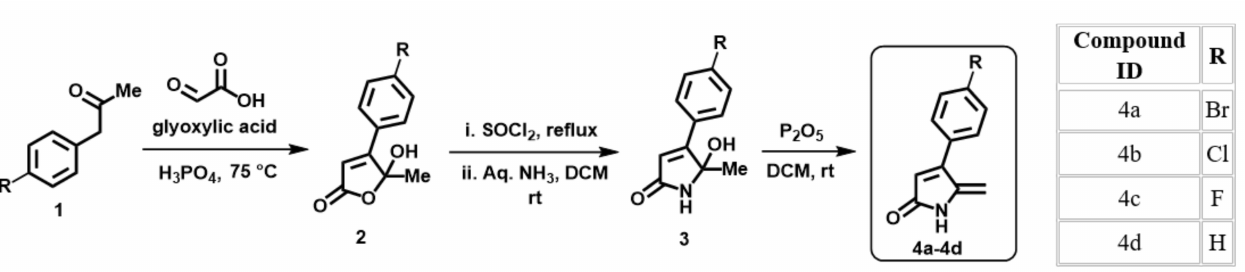
Figure 8. Step-by-step synthesis of halogenated dihydropyrrol-2-one molecules. Compound ID and respective halogen atom labelled as